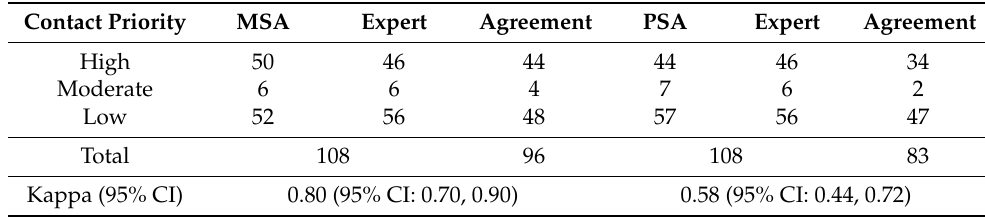
Table 3. Kappa agreement of contact priority between MSA and the experts vs. Present Self- Assessment (PSA) and the experts.